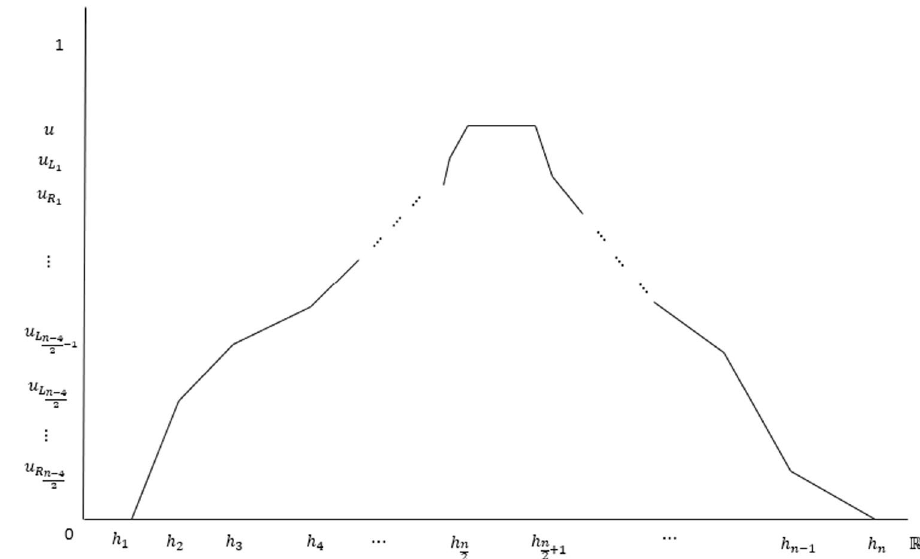
Fig. 7 Generalized ‘ N ’